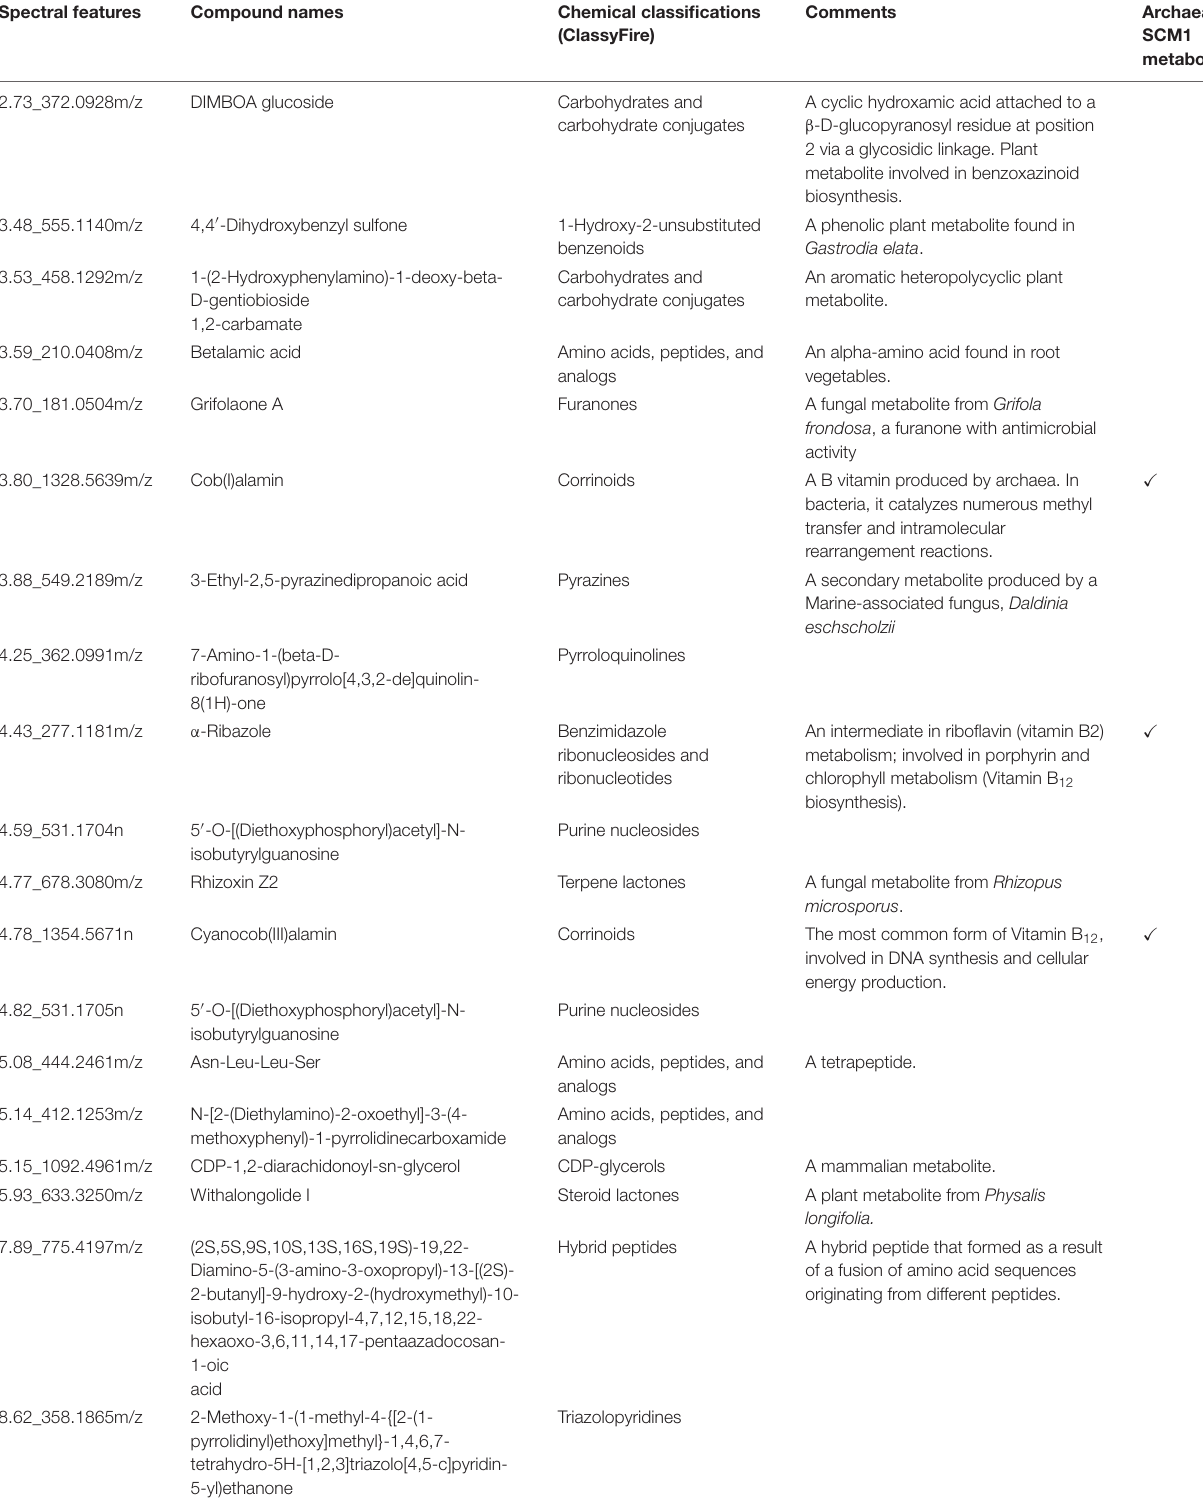
TABLE 1 | Chemical classifications and biological roles of the annotated spectral features that are postulated exometabolites of N. maritimus SCM1 detected under negative ion